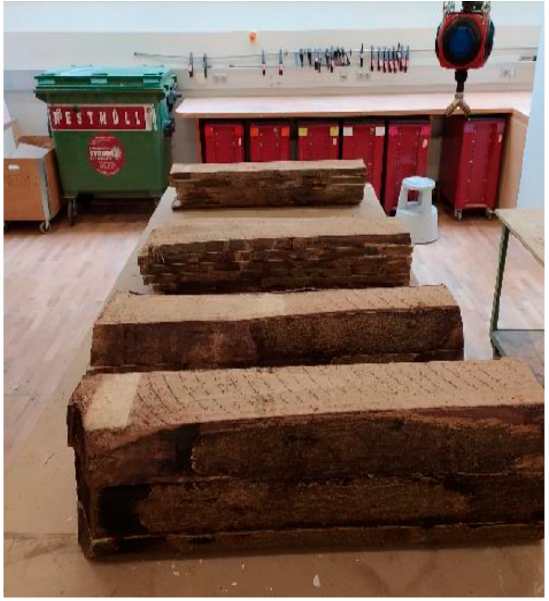
Figure 2. Four Paulownia logs extracted from two trees at different heights (0–1 m, 4.5–6 m).